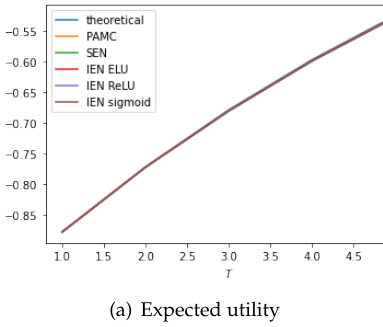
Figure 3. S t follows the 4/2 model with a market price of risk λ S utilities obtained with theoretical results and approximation methods versus investment horizon T ; and ( b ) shows the CERs versus investment horizon T given γ =